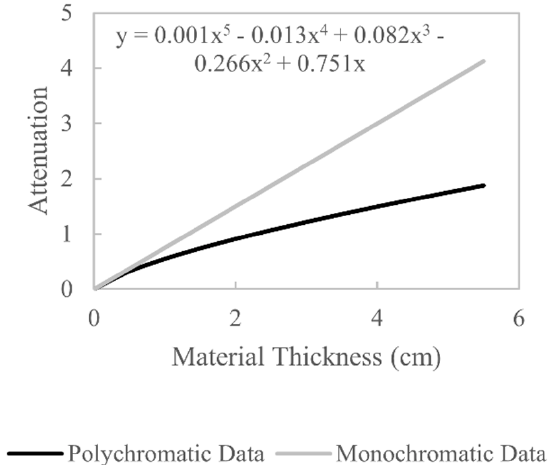
Figure 7. Polychromatic and monochromatic attenuation values for increasing material thicknesses. The polychromatic attenuation values are simulated using the estimated W ( E ) . A polynomial function is fitted to the polychromatic data, and the first-order coefficient is the gradient of the monochromatic line.